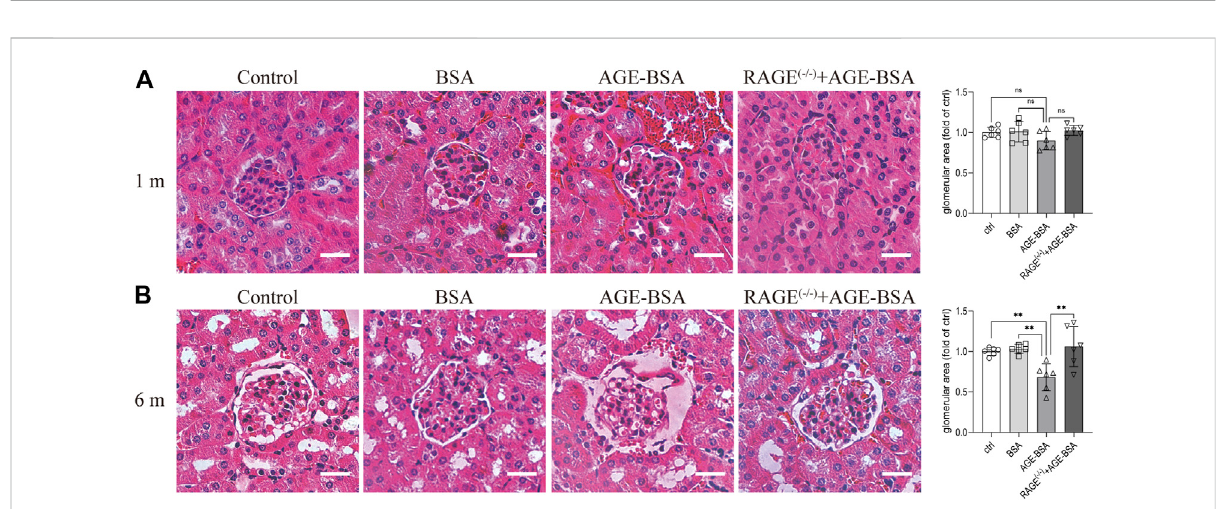
FIGURE 2 AGE-BSA induces RAGE-mediated renal disorganization with vessel dilation and congestion. HE staining of renal tissue was performed at 1 m (A) and 6 m (B) after treatment. Scale bar = 40 μ m. The glomerular area was quantitatively analyzed by ImageJ (right panels). n = 6. ** p <